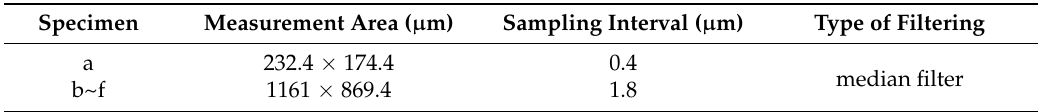
Table 1. Information about measurement of